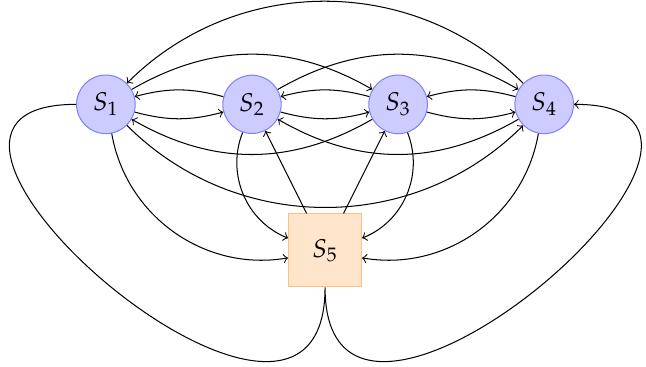
Figure 3. Graph of the states and state transitions.